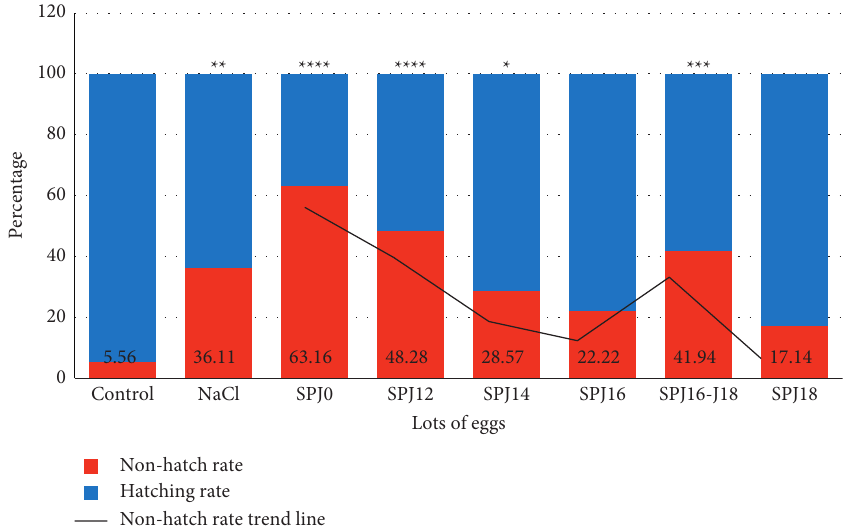
Figure 1: Nonhatching rate in different eggs batches. Eggs were incubated under normal conditions (37.7 ° C; 55% relative humidity; 0.06% CO 2 ; 1/60min of turning). Different treatments are made on different days. The nonhatching rate was then determined. Data are expressed as mean ± standard error of the mean (SEM) and analyzed by one-way ANOVA, followed by Tukey test ( p < 0 . 05) as compared to the respective parameter value of control groups. ∗ P < 0.05, ∗∗ P < 0.01, ∗∗∗ P < 0.001, ∗∗∗∗ P < 0.0001 significant difference from control. ns � not significant. SP J0 � injection of sulfadoxine-pyrimethamine before the start of incubation; SP J12 � injection of sulfadoxine-pyrimethamine on day 12 of incubation; SP J14 � injection of sulfadoxine-pyrimethamine on day 14 of incubation; SP J16 � injection of sulfadoxine-pyri- methamine on day 16 of incubation; SP J16-J18 � injection of sulfadoxine-pyrimethamine on day 16 and day 18 of incubation; SP J18 � injection of sulfadoxine-pyrimethamine on day 18 of incubation.